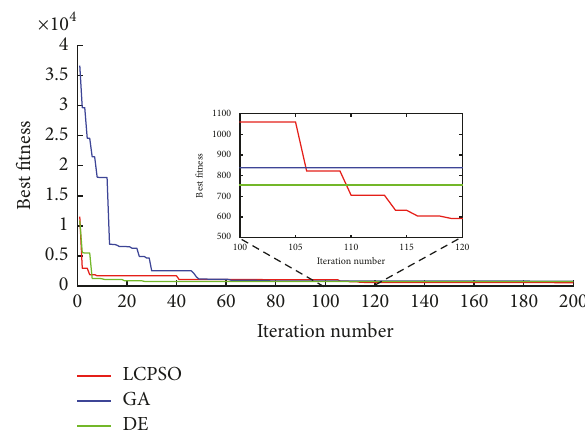
Figure 6: Convergence processes of the fitness functions.